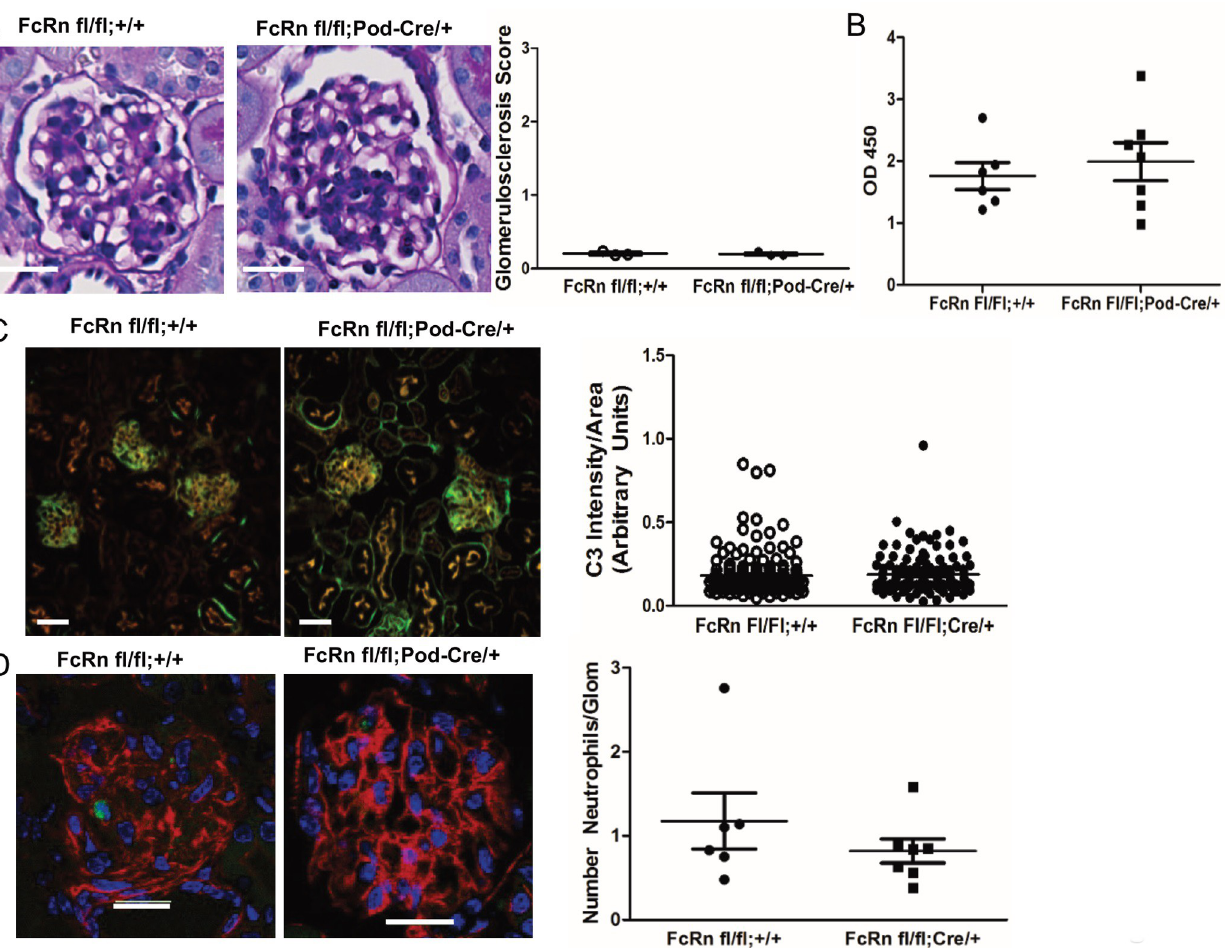
Fig 3. Characterization of podocyte-specific FcRn knockout mice and induction of anti-GBM nephritis. A . Left Panels: Representative images of glomeruli from 3 month old control (FcRn fl/fl;+/+) and podocyte-specific FcRn KO (FcRn fl/fl;Pod-Cre/+). Scale bar 10 μ m. Right Panel: minimal glomerulosclerosis at 3 months (n = 3 control and n = 3 KO mice) and no crescents were observed. B , Anti-rabbit IgG titers obtained from control and podFcRn KO mice demonstrated no significant difference between the two groups 3 days after the injection of the rabbit anti-mouse GBM antibody. C , Left panels: Representative immunofluorescent staining images of podFcRn KO and control mice for C3 (green) and actin (red) 3 days after injections of anti-mouse GBM antibody. Scale bar 20 μ m. There was no difference in C3 staining intensity between control and podFcRn KO (right panel; n = 6 control and n = 7 podocyte specific KO mice). D , Left panels: Representative images of immunofluorescent staining for Ly6 (green) for neutrophil quantification. Actin is blue. Scale bar 20 μ m. Right panel: there was no significant difference in the number of neutrophils per glomerular cross section between the podFcRn KO and controls (numbers of mice same as in E ).